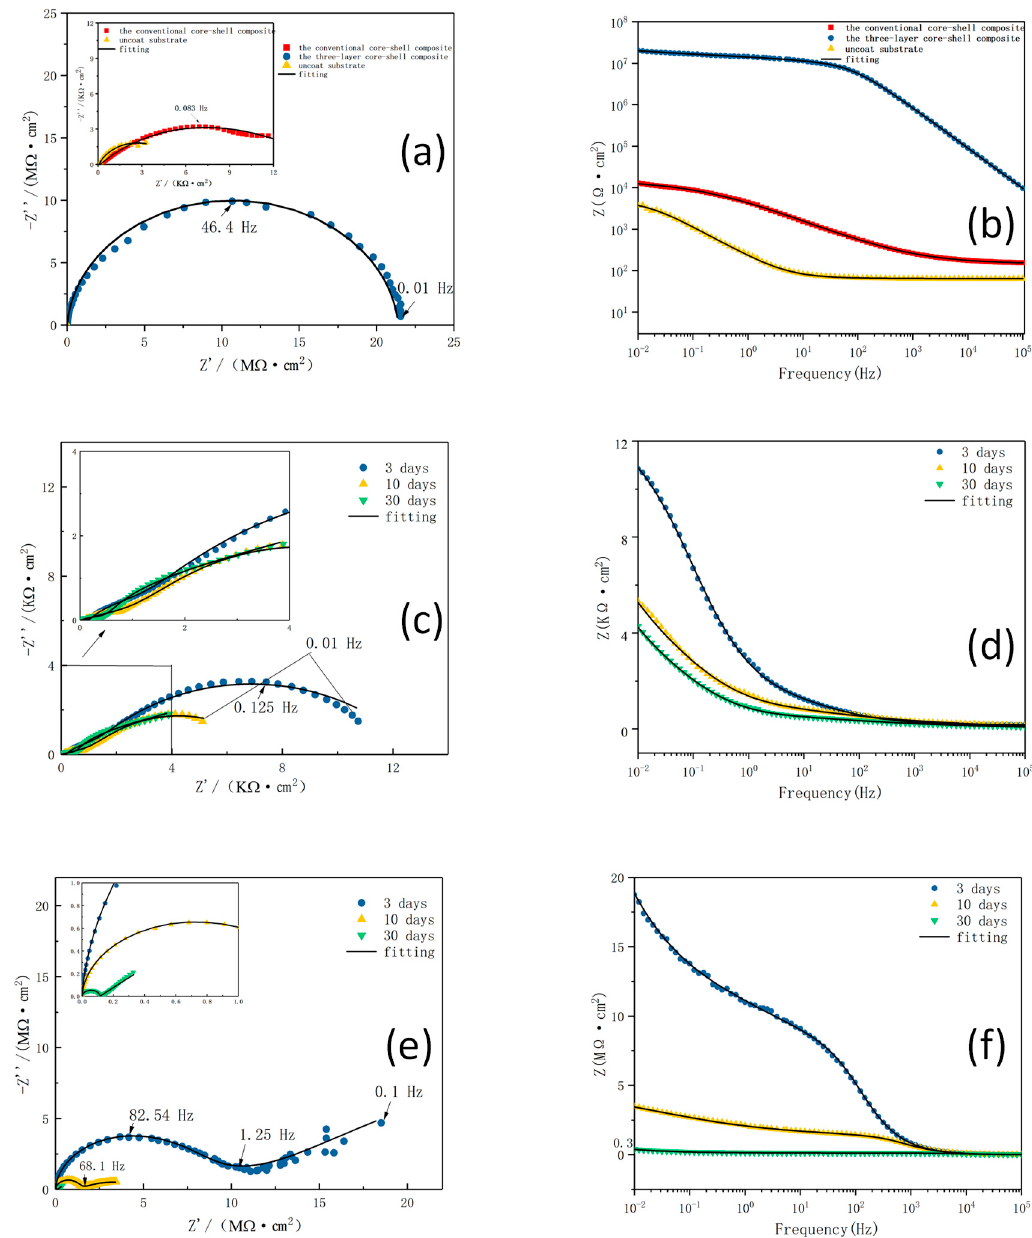
Figure 9. Nyquist plots ( left ) and Bode plots ( right ) of different samples: ( a , b ) at the initial immersion; and at different time intervals of immersion for ( c , d ) conventional core–shell structure and ( e , f ) three ‐ layer core ‐ shell structure.